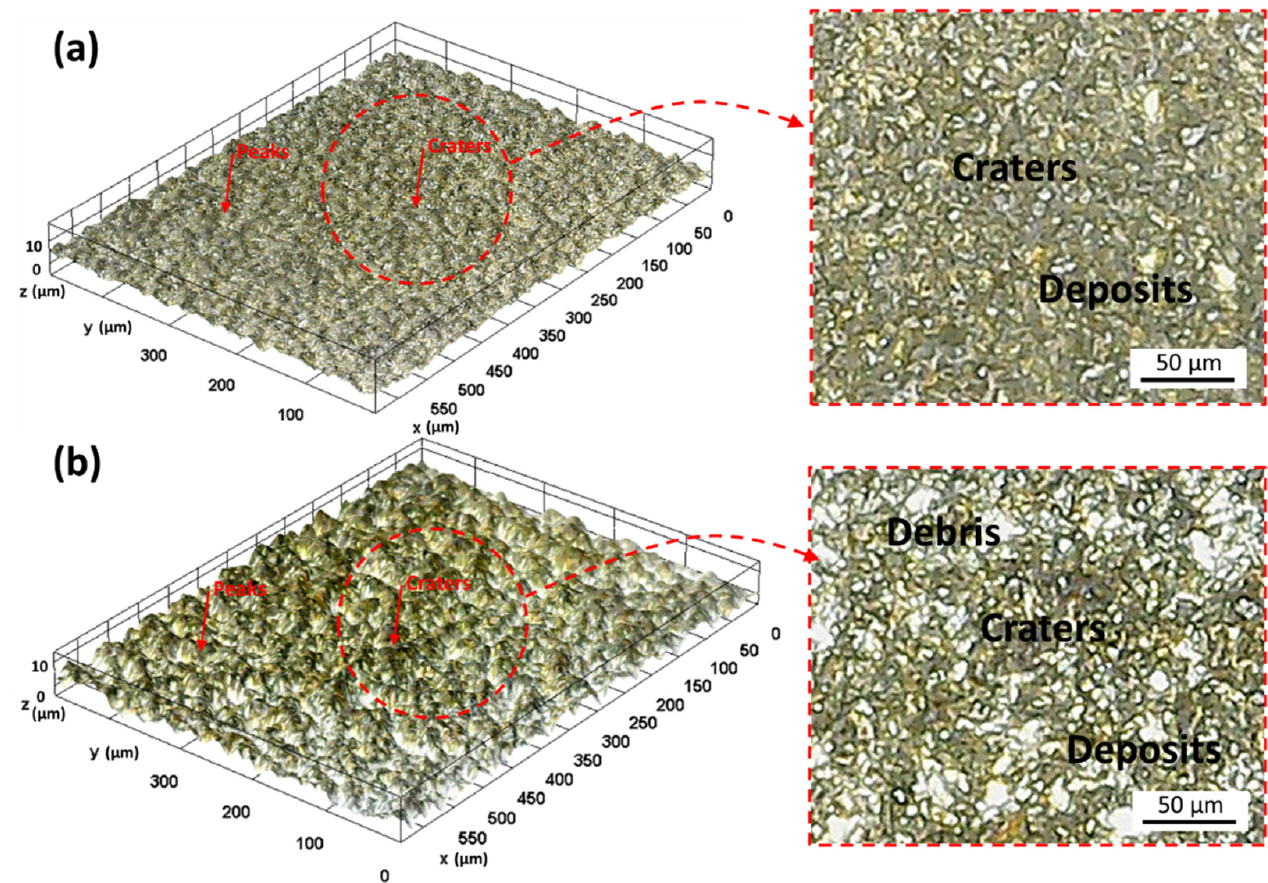
Figure 8. Surface micrographs ( a ) V S 40, F P 12, Ø N 4, W D 10 (low discharge energy); ( b ) V S 50, F P 4, Ø N 4, W D 8 (high discharge energy).